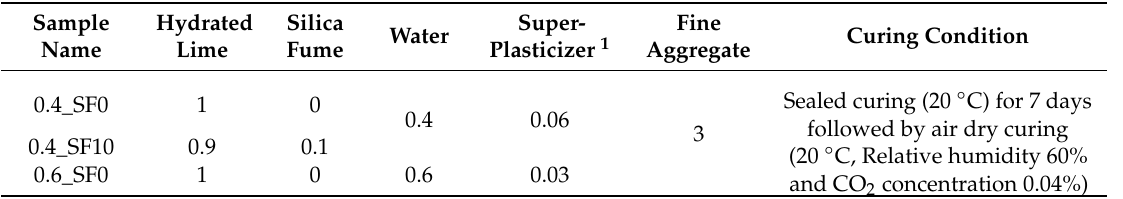
Table 2. Mix proportion of air lime mortars (wt % of